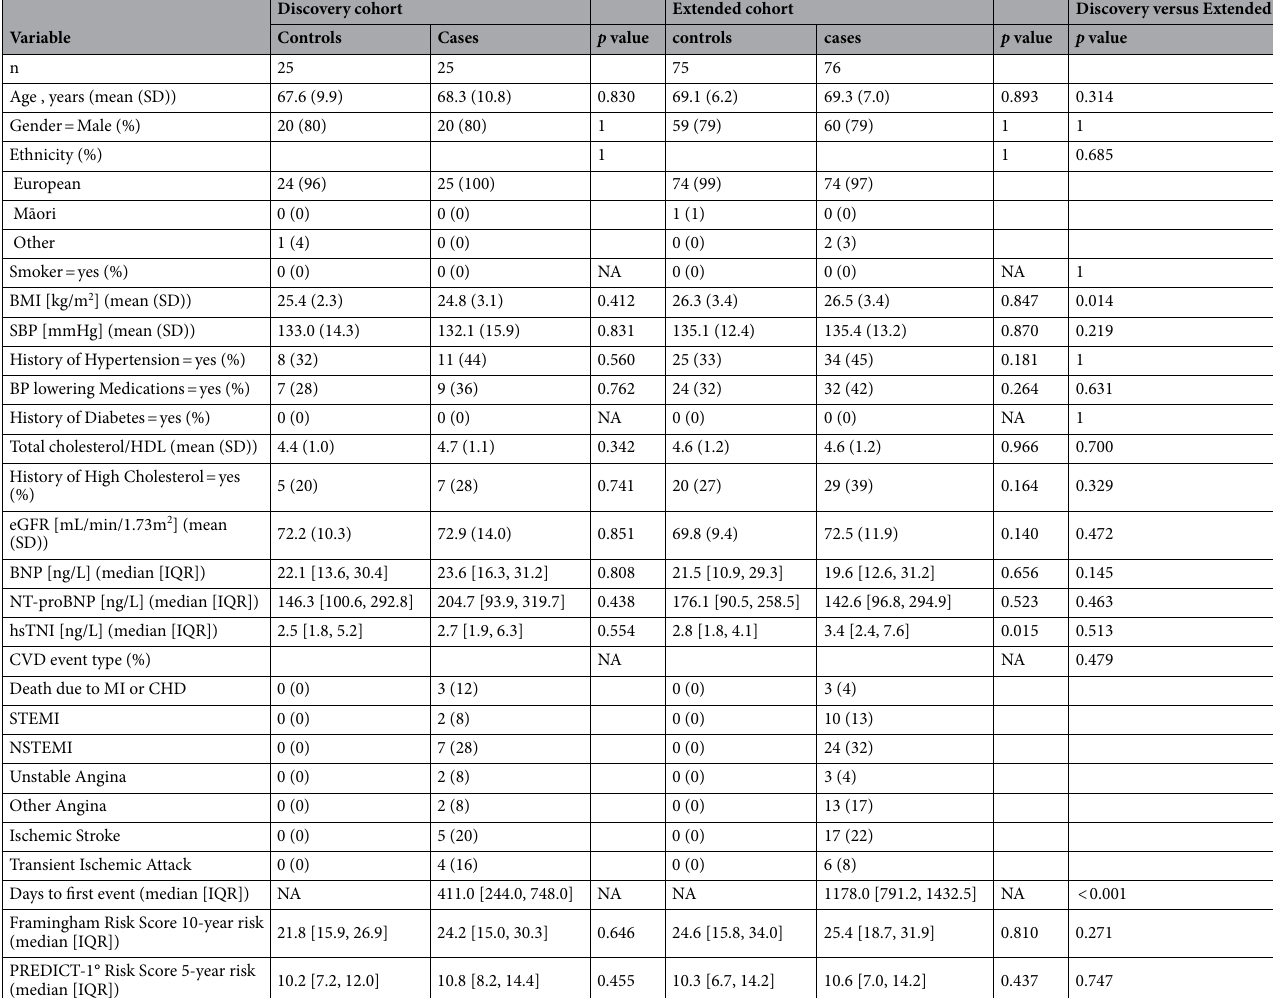
Table 1. Patient characteristics in the Discovery (n = 50) and Extended (n = 151) cohorts. SD standard deviation, BMI body mass index, SBP systolic blood pressure, BP blood pressure, HDL high density lipoprotein, eGFR estimated glomerular filtration rate, BNP B-type natriuretic peptide, NT-proBNP amino- terminal pro-hormone B-type natriuretic peptide, hsTNI high-sensitivity Troponin I, ACS acute coronary syndrome, PREDICT-1 ° NZ Primary Prevention Equations, CoD cause of death, MI myocardial infarction, STEMI ST-Elevation Myocardial Infarction, NSTEMI Non-ST-elevation myocardial infarction, CHD coronary heart disease. Where missing, values for the total cholesterol/HDL ratio (1 missing in Discovery cohort and 12 missing in Extended cohort) were set to the median value of the entire Hvols cohort (n = 3358), total cholesterol/HDL (women) = 3.82, total cholesterol/HDL (men) = 4.46. The NZ Deprivation quintile information was not available for this cohort and set to 3 for both men and women to calculate the PREDICT-1° Risk Score. Table generated using the ‘tableone’ (https ://githu b.com/kaz-yos/table one/) package within R/RStudio 17,18,39